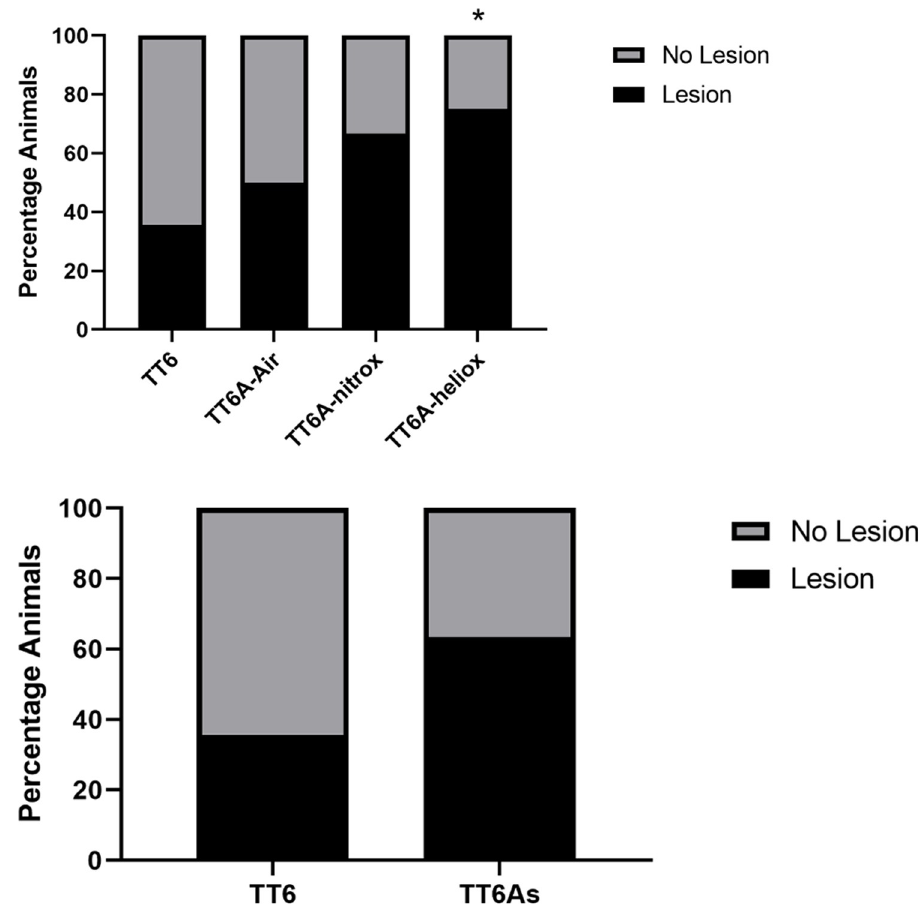
Fig 8. Bar graph showing the incidence of spinal cord lesion across treatment groups (A) with no significant difference among groups (chi-square test, p = 0.09), but a significant difference between TT6 and TT6A-heliox (chi- square test, p = 0.045, OR 5.4, 95% CI 0.98–29.67), and no significant difference between treatment profiles (B, Chi- Square Test, p = 0.07, OR 3.12, 95% CI 0.88–11.05). increase in total lesion area there was a 33% increase in odds of neurologic deficit (Logistic Regression, p < 0.0001, Model: log odds = -1.382+5.181 � X, Area under the ROC curve = 0.8724, 95% confidence interval (0.7710 to 0.9737)).